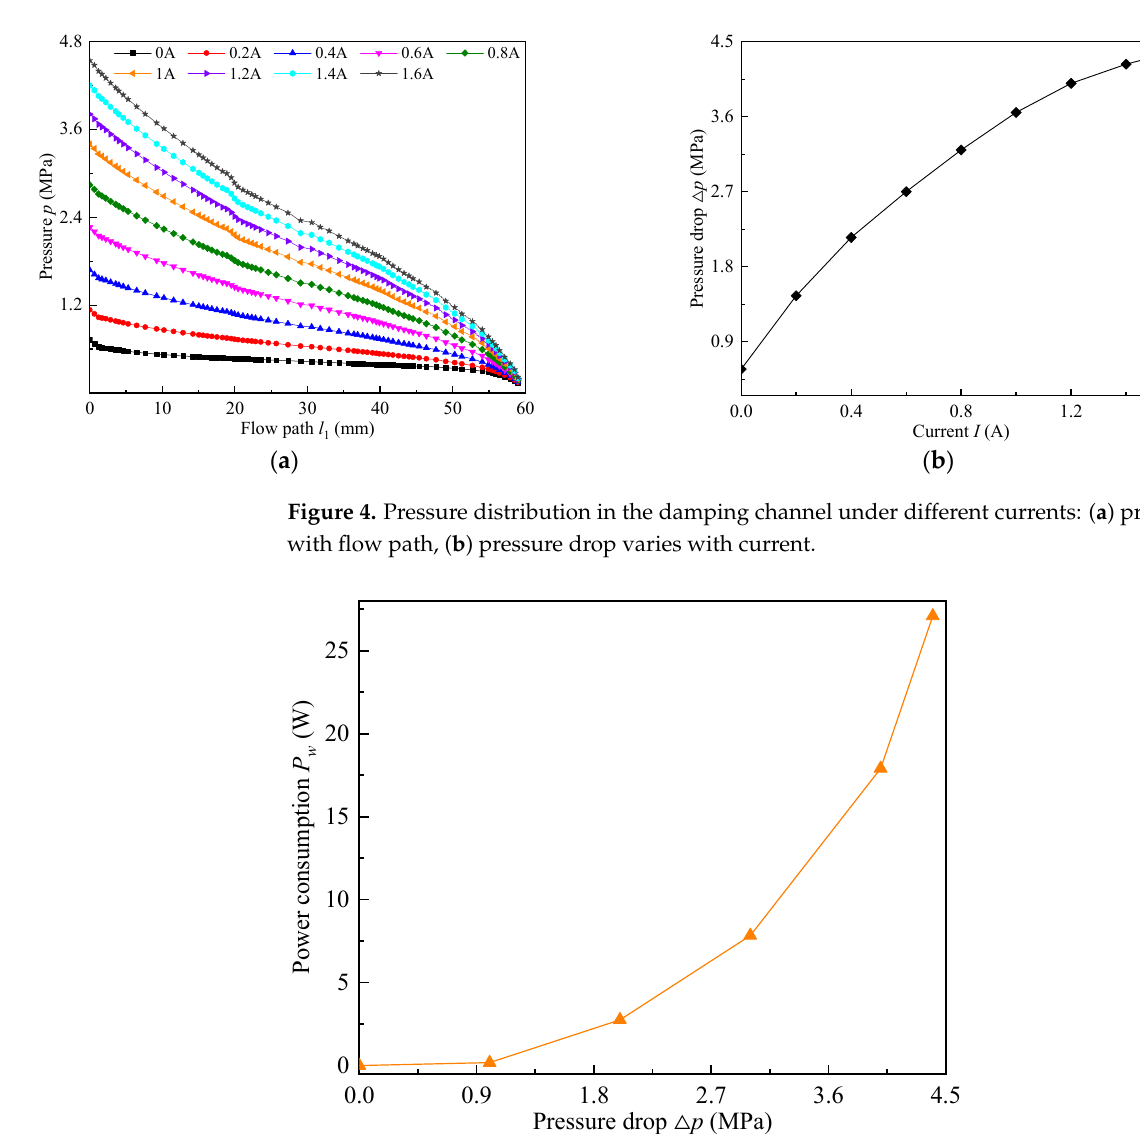
Figure 5. Power consumption of MR valve under different pressure drops.